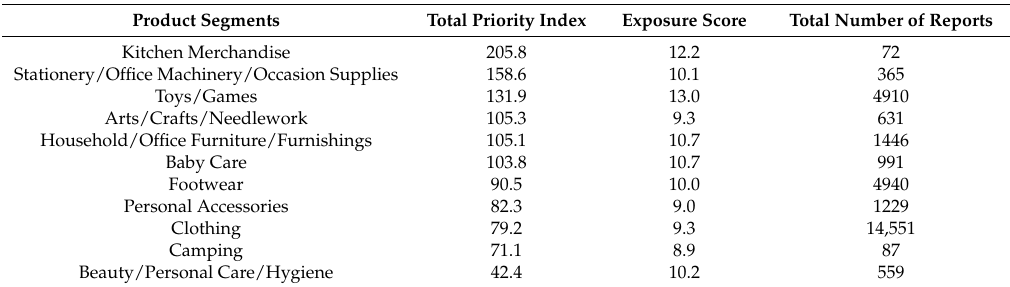
Table 4. Average total priority indices and exposure scores across product segments. Total number of reports in each product segment are also